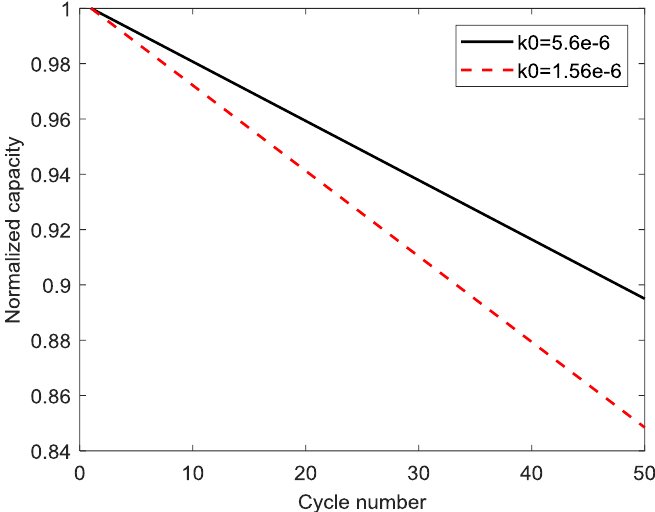
Figure 7. Discharge curve comparisons with different reaction-rate constants ( k 0 = 5.6 × 10 − 6 , 1.5 × 10 − 6 ).